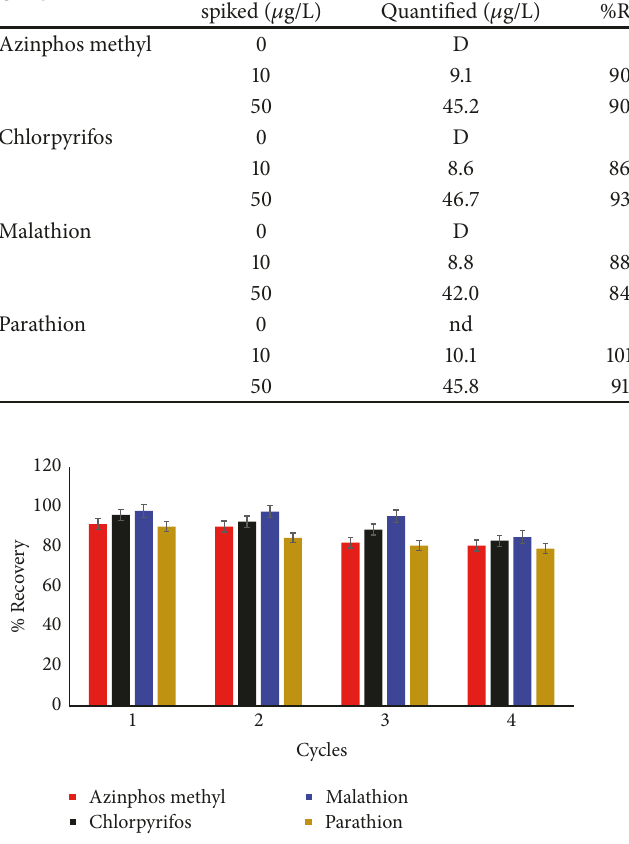
Table 3: Determination of OPPs in water sample (nd = not detected and D = detected). OPPs